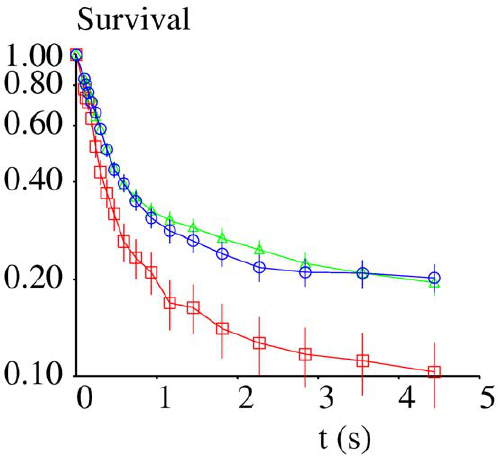
Figure 2. Lifetime of nonspecific arrests. The figure shows the survival curves of binding events recorded between ICAM-1-coated surfaces and microspheres coated with irrelevant antibodies. Squares: wall shear rate 9.3 s 2 1 , microsphere velocity 11.25 m m/s, 213 binding events recorded. Crosses: wall shear rate 18.5 s 2 1 , microsphere velocity: 22.5 m m/s, 717 binding events recorded. Circles: wall shear rate 29.4 s 2 1 , microsphere velocity: 35.7 m m/s, 526 binding events recorded. Vertical bar length is twice the standard error.